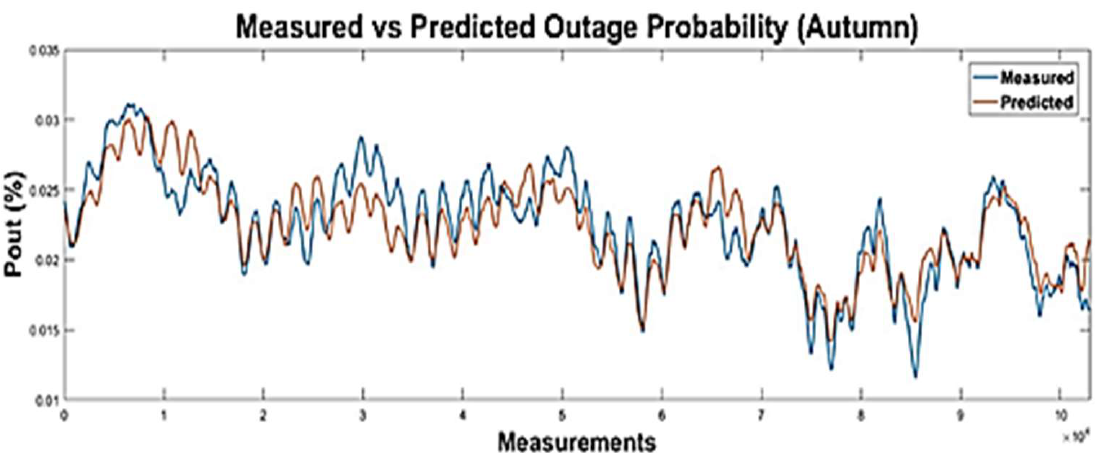
Figure 15. Measured vs Predicted outage probability time series for autumn.